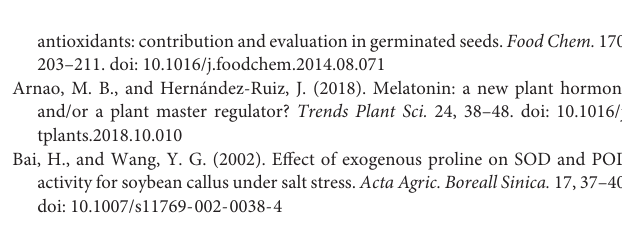
Supplementary Figure 2 | Salt-stress reduced growth parameters of different alfalfa varieties. CK: Water. NaCl: 200, 225, 250, 275, and 300 mM. For each replicate, one hundred alfalfa seeds were surface-sterilized, spread evenly on two layers of filter paper which were presoaked with 5 ml treatment solution, and placed in a Petri dish at 20 ◦ C in an illuminating incubator. (A) Fresh weight. (B) Dry weight. (C) Relative water content. n = 40. A t -test was performed between samples in different treatment groups. Different numbers indicate significant differences ( p (cid:53) 0.05) between different treatments. A, Algonquin; B, Bingchi; G, Golden Empress; W, Weiner. Supplementary Figure 3 | Different concentrations of MT treatment. The experiment was carried out as the experiment in Figure 1 unless adding different concentrations of MT. Supplementary Figure 4 | Different concentrations of 5-HT treatment. The experiment was carried out as the experiment in Figure 1 unless adding different concentrations of 5-HT. Supplementary Figure 5 | Effects of combined treatment on fresh weight (A) , dry weight (B) , and relative water content (C) of different alfalfa varieties under salt stress. CK: Water. NaCl: 250 mM. MT: 150 µ M. 5-HT: 1 µ M. Seeds were germinated for 10 days under different treatments, and 30–60 seedlings from each replicate were used for measurement. Water content = [(Fresh weight − Dry weight)/Fresh weight] × 100%. Error bars show the SE between biological replicates and a t -test was performed between different treatment groups. Different numbers indicate significant differences ( p (cid:53) 0.05) between samples. A, Algonquin; B, Bingchi; G, Golden Empress; W, Weiner. Supplementary Figure 6 | Measurement of SOD (A) , CAT (B) , and K + /Na + (C) . The experiment was carried out as the experiment in Figure 3 . Supplementary Figure 7 | Effects of H 2 O 2 treatment on germination and growth of different alfalfa varieties. CK: Water; NaCl: 250 mM. For each replicate, one hundred alfalfa seeds were surface-sterilized, spread evenly on two layers of filter paper which were presoaked with 5 ml treatment solution, and placed in a Petri dish at 20 ◦ C in an illuminating incubator. (A) Germination rate. Germinated seeds were calculated on the 10th day and the germination rate was determined. Three biological replicates were performed and error bars show the SE values. (B) Relative water content. (C) Fresh weight. (D) Dry weight. n = 30. A t -test was performed between samples in different treatment groups. Different numbers indicate significant differences ( p (cid:53) 0.05) between different treatments. A, Algonquin; B, Bingchi; G, Golden Empress; W: Weiner. Supplementary Figure 8 | DAB-staining of alfalfa seedlings. Supplementary Figure 9 | Phenotypic observation of another M . truncutula line. The experiment was carried out as the experiment in Figure 9 . Supplementary Figure 10 | The qRT-PCR confirmation of selected unigenes from transcriptome data. The mRNA levels of 20 unigenes were detected by qRT-PCR experiment using gene-specific primers. The housekeeping gene, MsActin was used as the reference. Data represent mean values for three independent biological replicates. SE is indicated by vertical bars. Different numbers indicate significant differences ( p (cid:53) 0.05) between different treatments. CK, Water. NaCl, 250 mM. NaCl + MT, 250 mM NaCl + 150 µ M MT. Supplementary Table 1 | The qRT-PCR primers for the detection of unigene expression. Supplementary Table 2 | The statistical output of RNA-seq data for selected differentially expressed genes (DEGs) in Figure 10